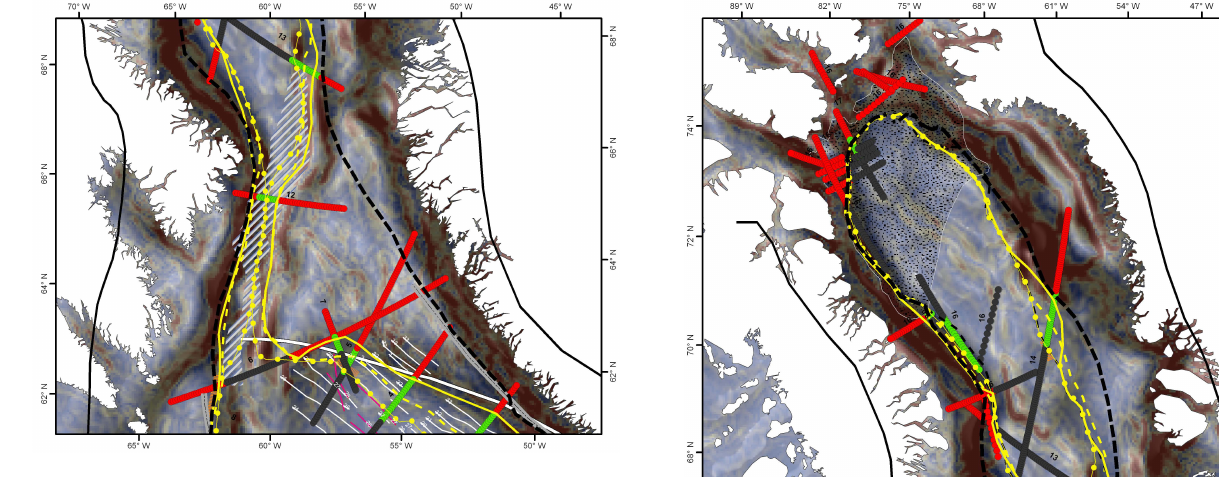
Fig. 3. Interpreted crustal structure and alternative COB models in Davis Strait. Key is the same as for Fig. 2.